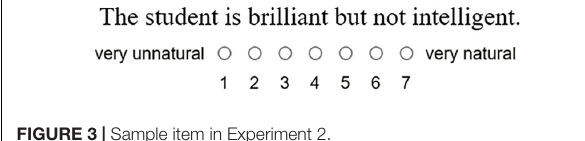
FIGURE 3 | Sample item in Experiment